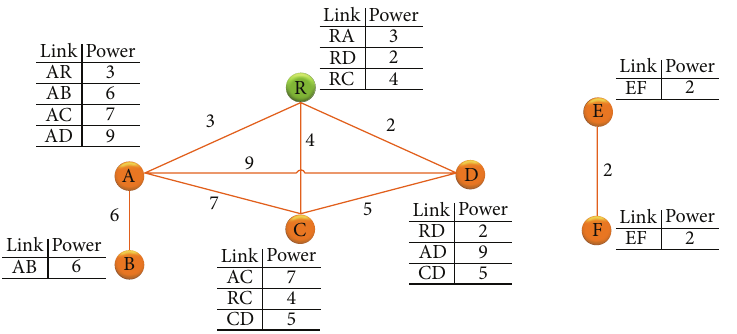
Figure 5: Link power and PCTs of the TAN in the example.